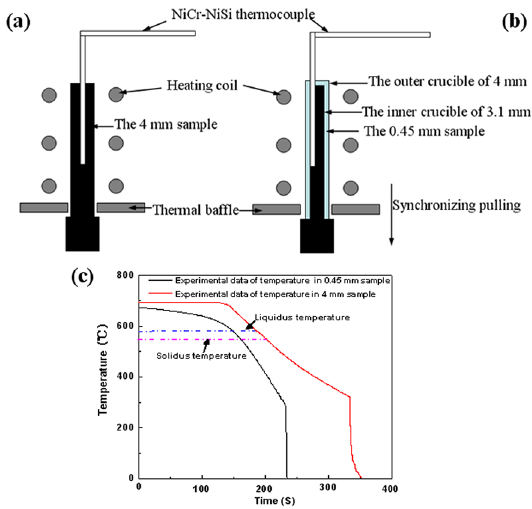
Figure 2. The schematic of the temperature gradient ( G ) measurement in different sizes samples: (a) the 4 mm sample, (b) the 0.45 mm sample, and (c) the experimental date of temperature in different sizes